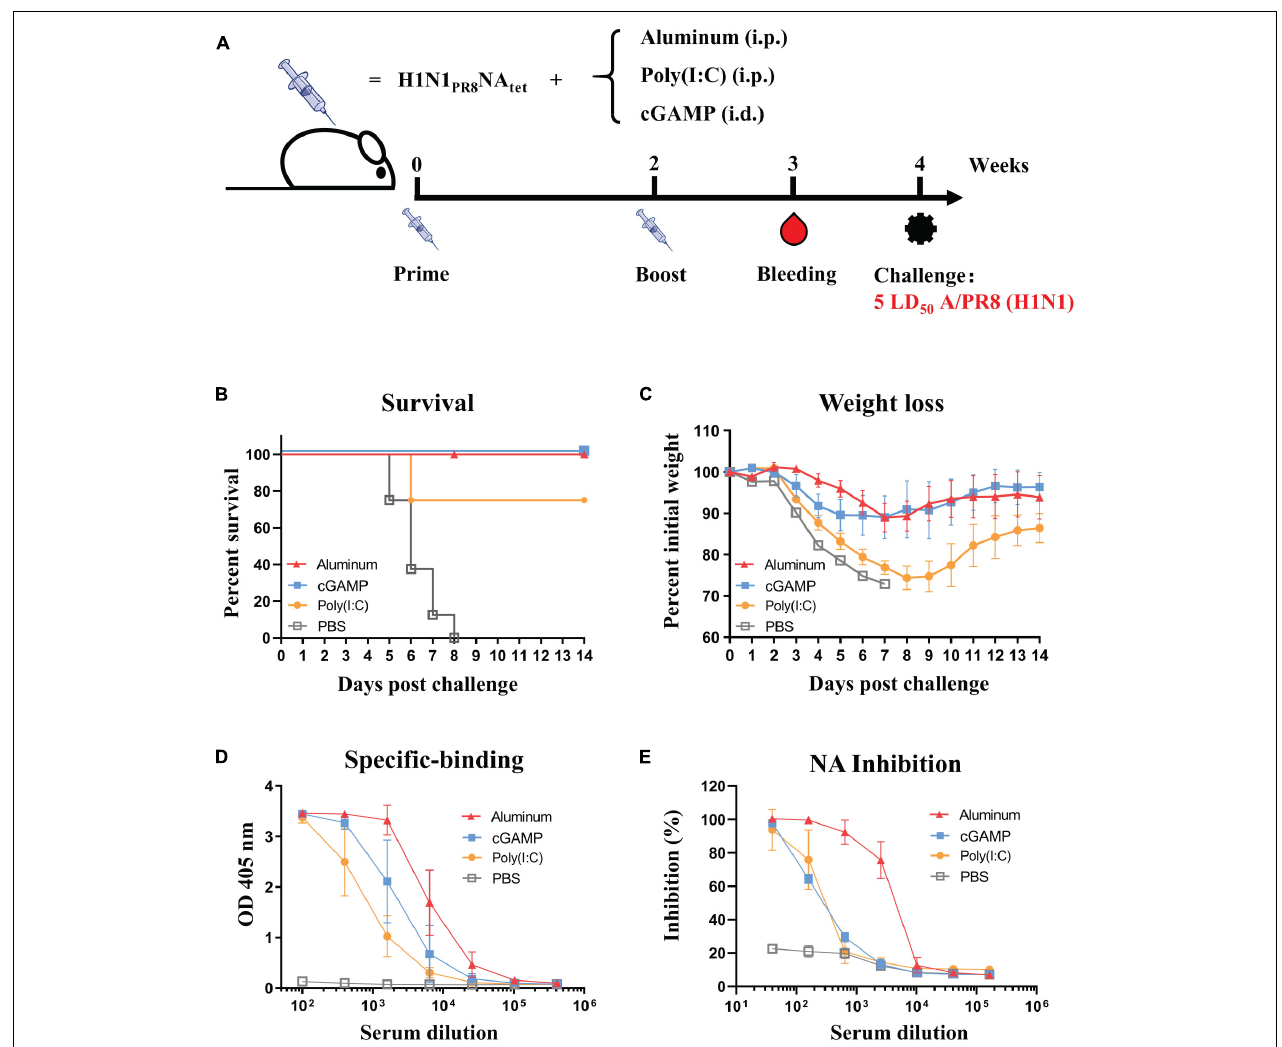
FIGURE 4 | Effect of three adjuvants—aluminum, cGAMP, and Poly(I:C)—on the protective efficacy and humoral response induced by H1N1 PR 8 NA tet tetramer. (A) Six- to eight-week-old BALB/c mice were immunized twice at 2-week interval with 20 µ g of H1N1 PR 8 NA tet protein adjuvanted with aluminum ( n = 8, i.p.), cGAMP ( n = 4, i.c.), or Poly(I:C) ( n = 4, i.p.), respectively. The mice were immunized with phosphate-buffered saline (PBS) as control ( n = 4, i.p.). Sera were collected at 1 week after the final immunization; then, the mice were challenged with 5 LD 50 of A/PR8 (H1N1) virus intranasally (i.n.) at 2 weeks after the final immunization. (B,C) The survival rates (B) and weight loss (C) were monitored for 14 days post-infection. (D) The serum from individual mice in each experimental group was tested for neuraminidase (NA)-specific antibody levels against H1N1 PR 8 NA tet protein via ELISA. (E) The NAI activity of mice serum against NA of A/PR8 (H1N1) was tested via enzyme-linked lectin assay